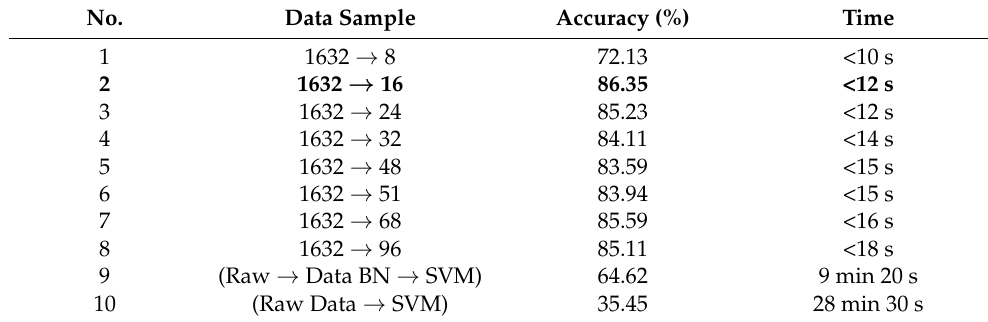
Table 3. Feature dimension reduction using SVD.